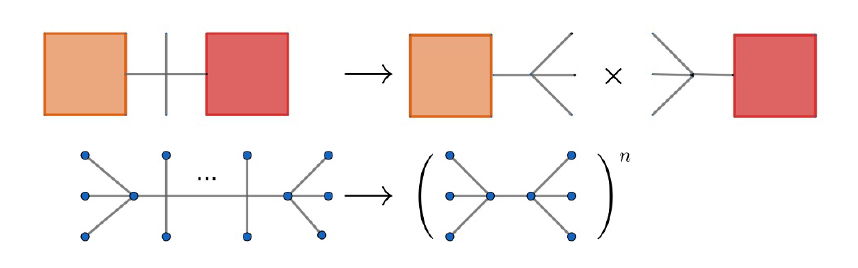
Figure 11 . The upper (cid:12)gure shows the splitting into lower dimensional polytopes. The lower (cid:12)gure shows explains why the Stokes polytope for this case is a hyper-cube.